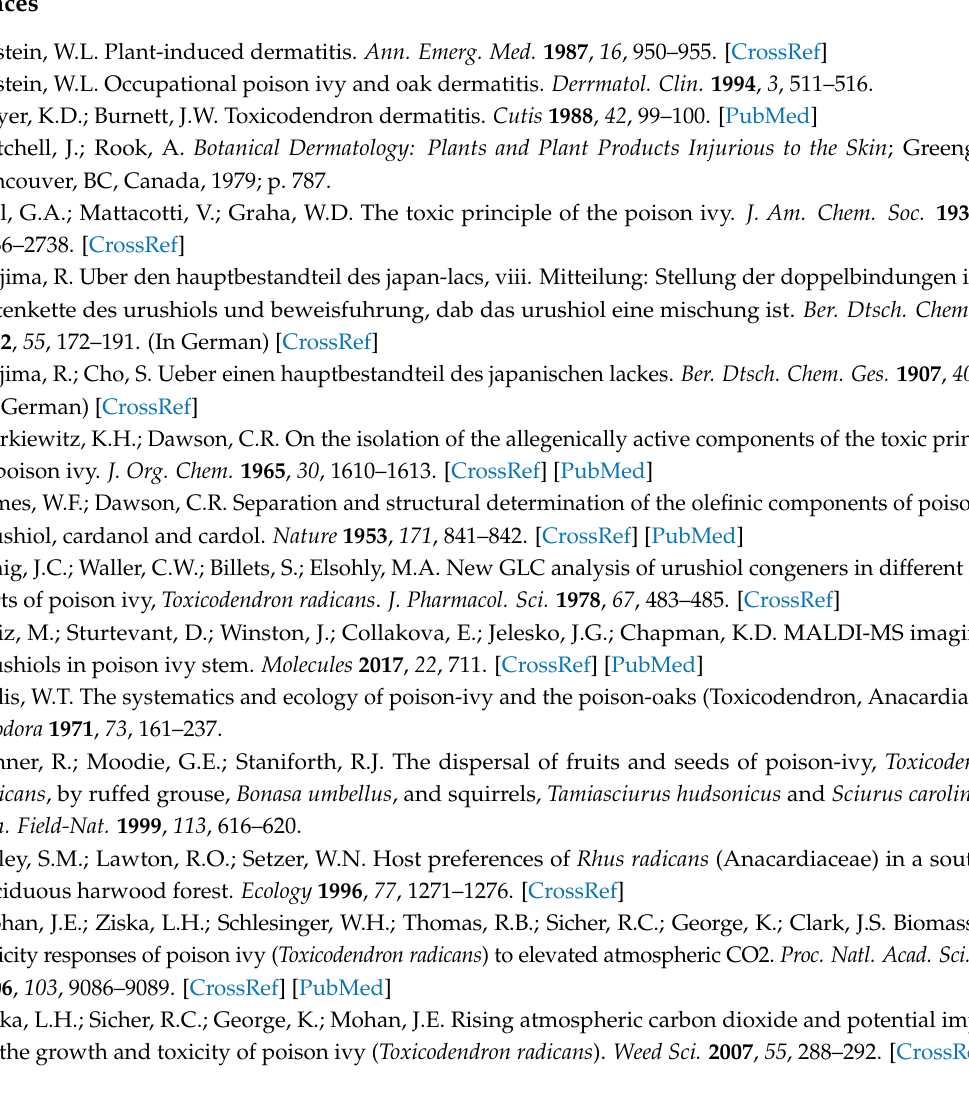
Figure S1: Blobplot of Leaf A, Figure S2: Blobplot of Leaf B, Figure S3: Blobplot of Root A, Figure S4: Blobplot of Root B, Figure S5: Relative gene expression between roots and leaves in genes matching GO term “Biological Processes”, Figure S6: Relative gene expression between roots and leaves in genes matching GO term “Cellular Component”, Figure S7: Relative gene expression between roots and leaves in genes matching GO term “Molecular Function”, Table S1: GO terms enriched in leaves compared to root tissue, Table S2: GO terms enriched in root vs. leaf tissue, Table S3: GO terms enriched in genes core to Anacardiaceae, Table S4: SSR primer